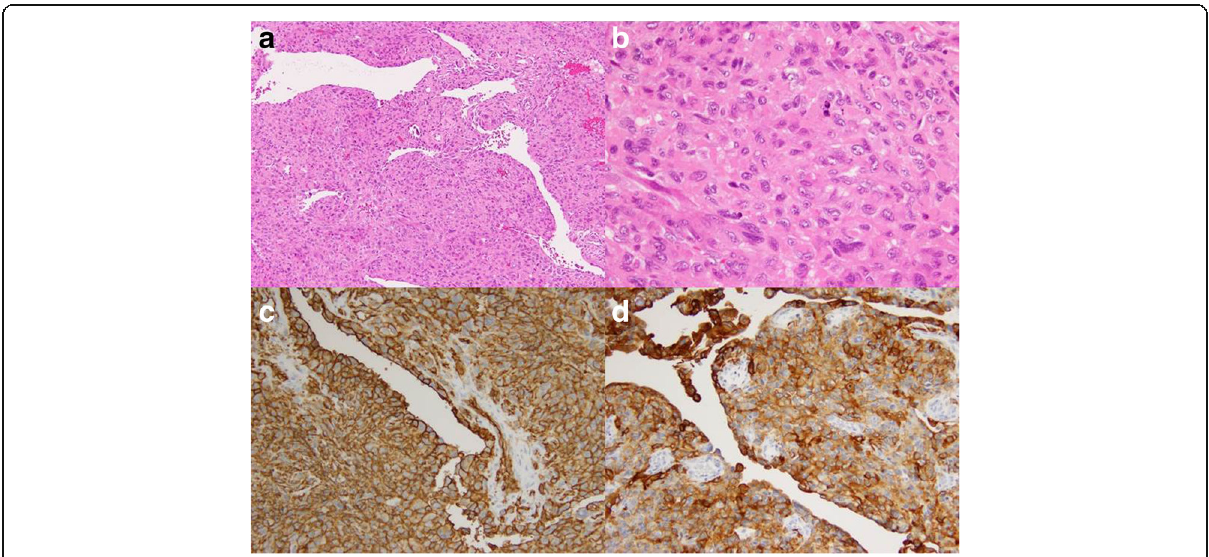
Fig. 3 Tumor cells are epithelioid and arranged in a large sheet-like pattern with microcalcification in hematoxylin and eosin staining ( a , b ). CD34 is strongly and diffusely expressed in the cytomembrane ( c ) and cytokeratin (AE1/AE3) is also expressed in the cytoplasm of most tumor cells ( d